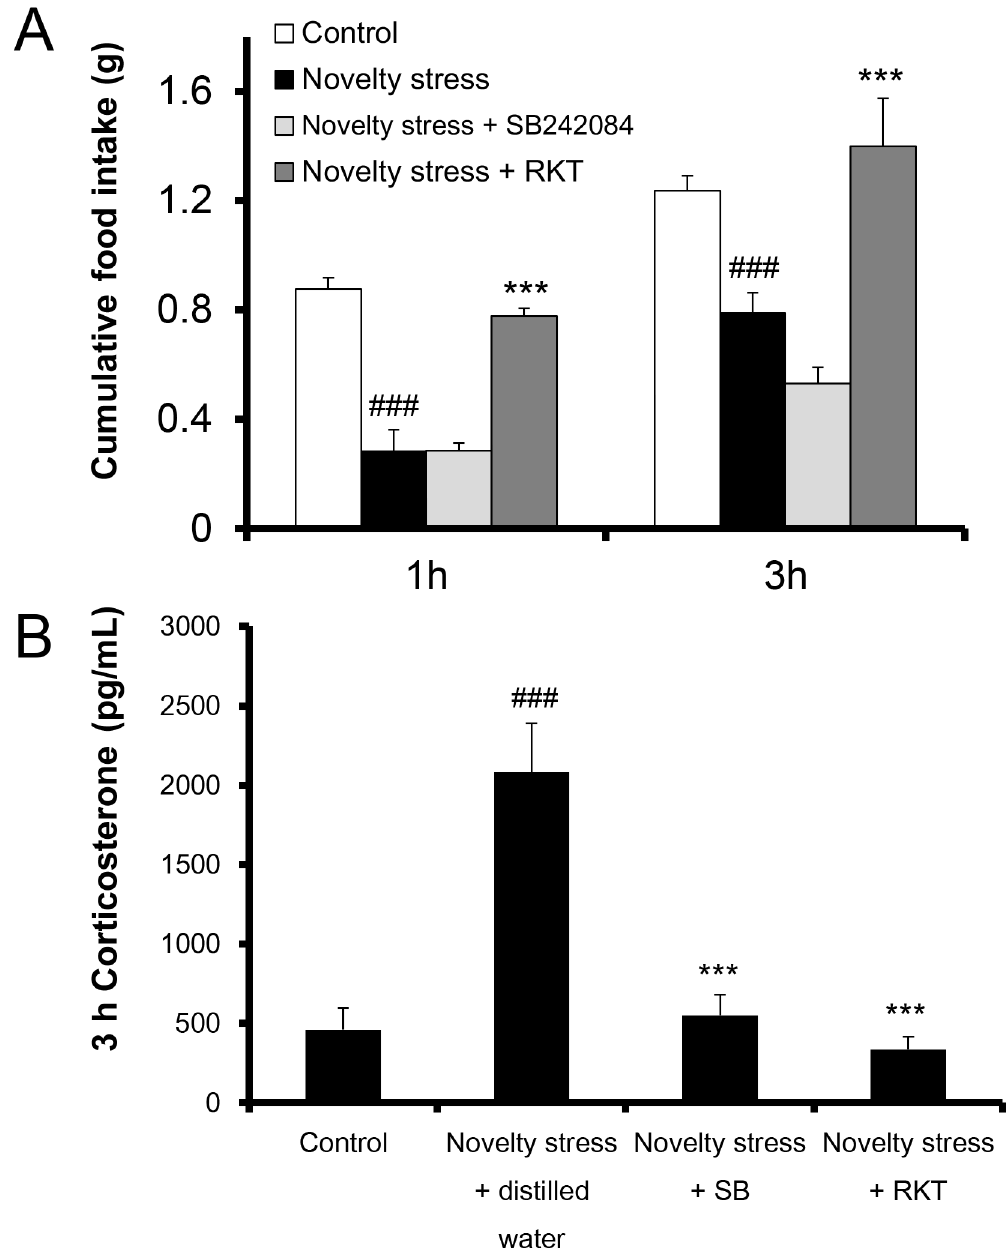
Fig 1. Effects of the 5-HT 2C R antagonist and the endogenous ghrelin enhancer on cumulative food intake and the plasma corticosterone level in aged female mice exposed to novelty stress. 5-HT 2C R antagonists, SB242084(6 mg/kg, PO) or RKT(1000 mg/kg, PO) was administered immediately after stress exposure.(A) Cumulative food intake (1 h and 3 h) and (B) plasma corticosterone levels (3 h) after stress exposure was determined in 18 h fasted aged female mice. Data are presented as the mean ± SEM (n = 5–10). ###, p < 0.001 vs. control group, *** , p < 0.001 vs. novelty stress group. hypothalamic neuropeptide Y (NPY) or agouti-related protein (AgRP) significantly decreased compared with the expression levels in the young mice. In contrast, the expression levels of NPY and AgRP were significantly increased in stressed, aged female mice. Proopio- melanocortin (POMC) expression did not change in any of the groups. The hypothalamic